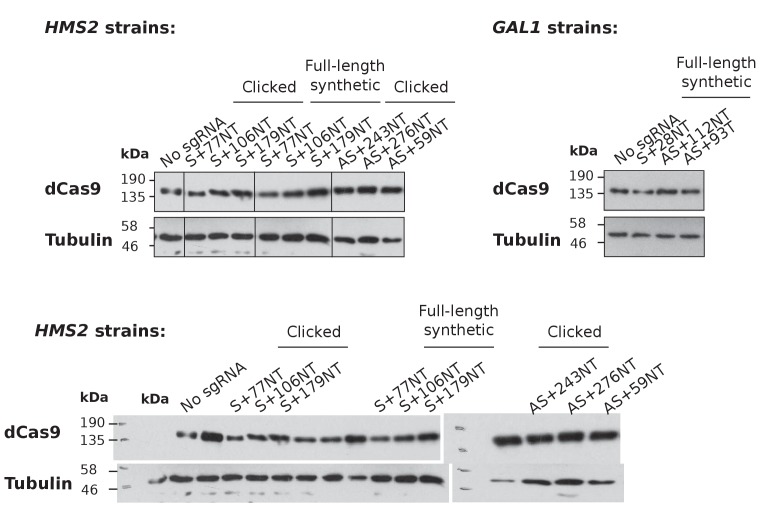
Levels of dCas9 protein in the experimental strains.Western blots showing levels of dCas9 produced in the strains expressing the indicated sgRNAs against HMS2 (left panel) and GAL1 (right panel). HMS2 strains constructed using the clicked and control full-length synthetic DNA oligos are shown. Tubulin levels are used as a loading control. Images are taken from the same gels with the same exposure times but with some lanes spliced out (indicated with vertical lines).